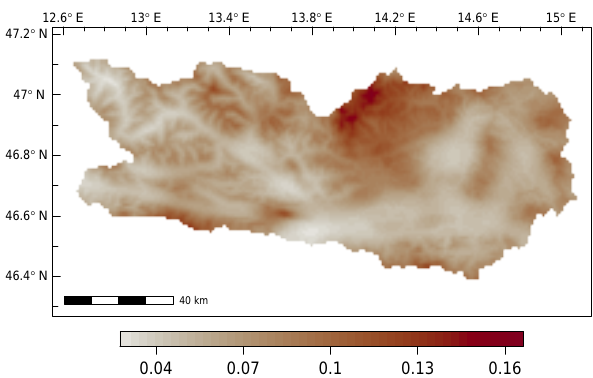
Figure 7. Climatological number of flashes (expected values) in Carinthia on the 1km × 1km scale for 20 July.